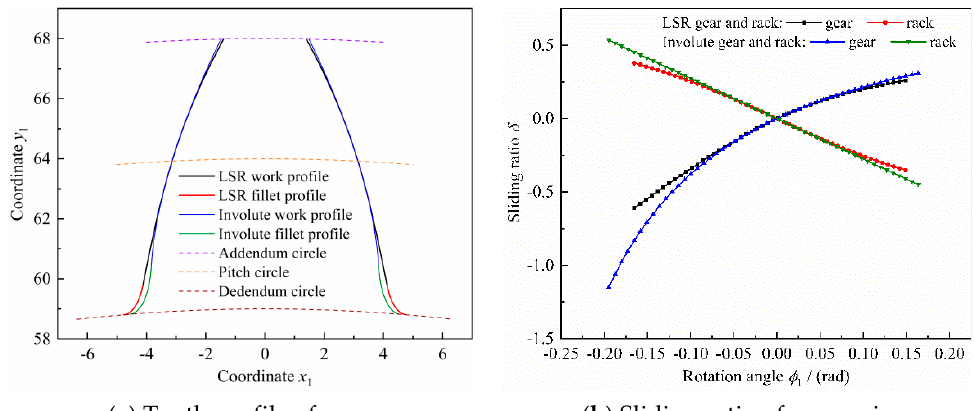
Figure 3. Tooth profile and sliding ratio of gear pair.